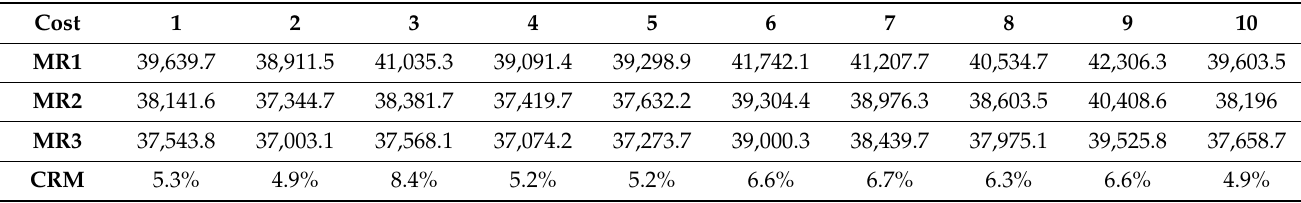
Table 8. Computational results of the third instances set in Case